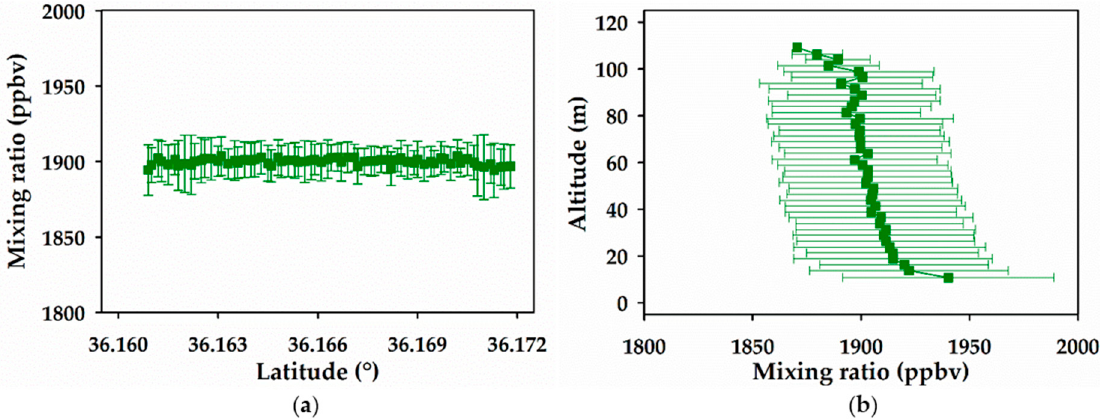
Figure 9. ( a ) The horizontal and ( b ) the vertical flight paths measuring the variable mixing ratio of (green square) CH 4 during the morning of 28 June, 2017 from 7:06 to 7:57 am (UTC–5 h).